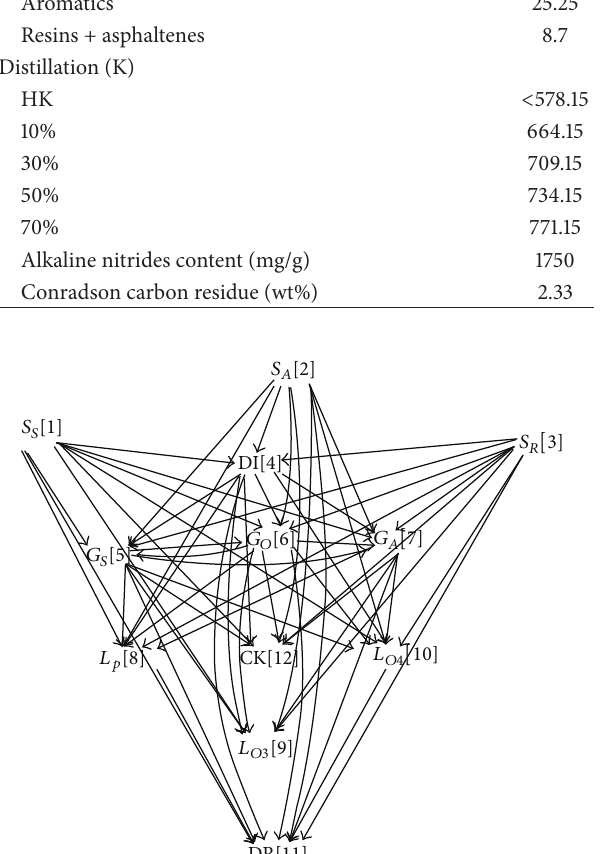
Figure 3: Twelve-lump kinetic model network [6].